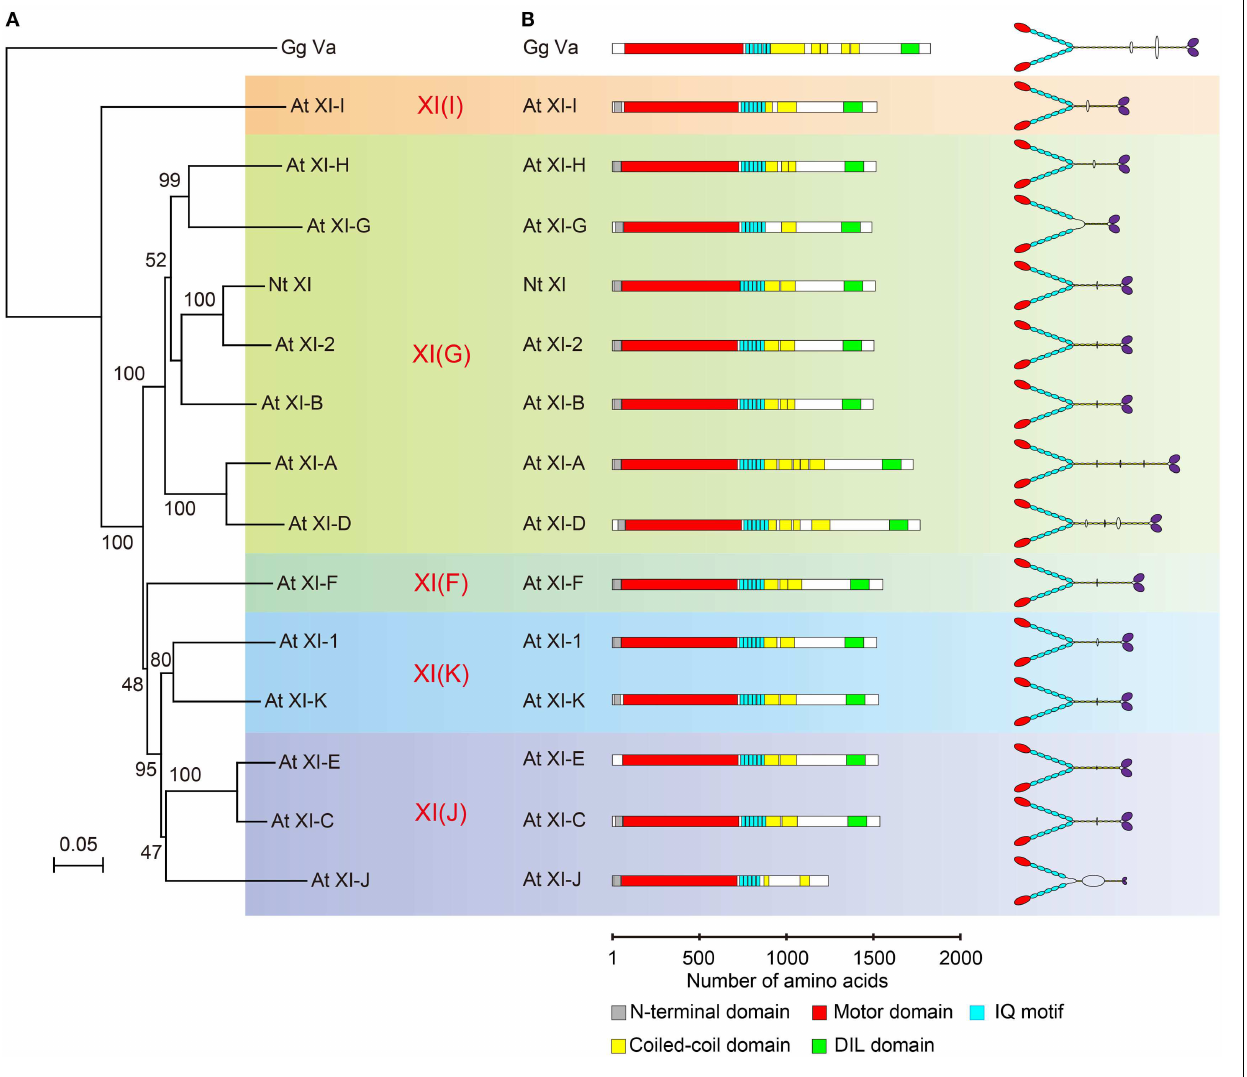
FIGURE 3 | (A) Phylogenetic tree for the motor domain of plant myosin XIs. Numbers indicate percentage bootstrap value of 10,000 trials. Each color represents lineages determined by Avisar et al. (2008b). (B) Primary structure